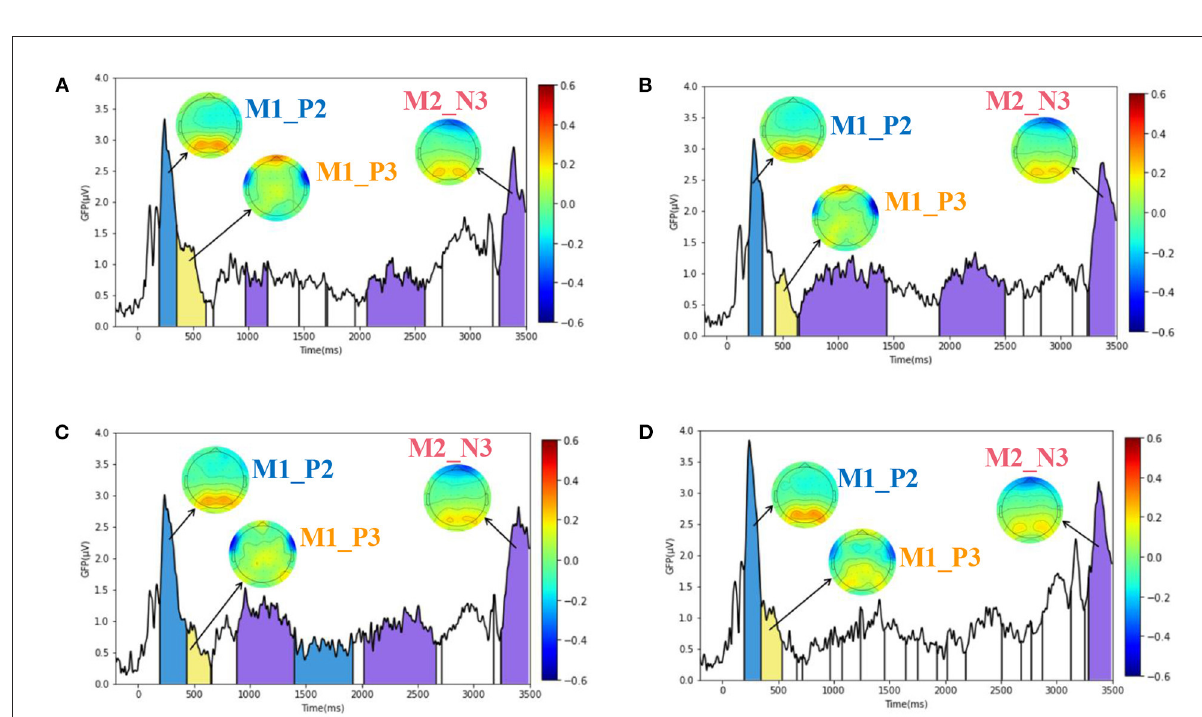
FIGURE7 ERP microstate results of spatial decision task under four stimuli (H, Q, T, None). (A–D) Plotted the GFP curves and similar microstates of decision task under H, Q, T, and None emotional stimuli, respectively. There are three similar microstates, namely, M1_P2 microstate, M1_P3 microstate, and M2_N3 microstate. The corresponding time of occurrence corresponds to the blue, yellow and purple regions in each image.